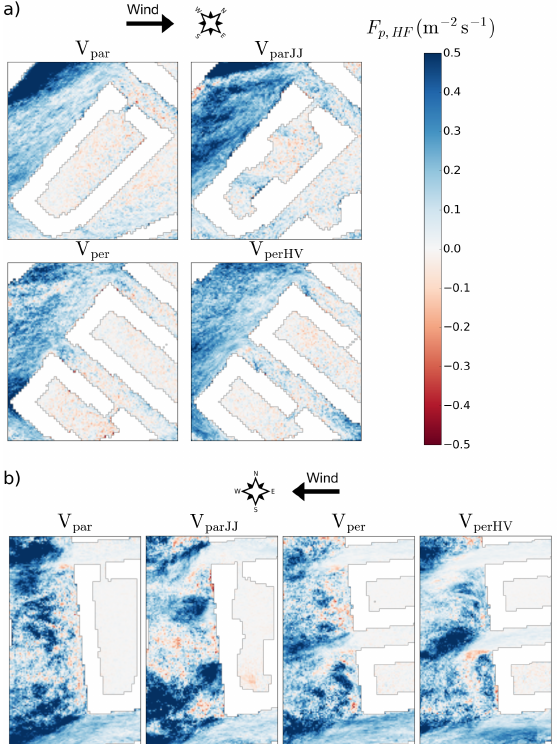
Figure A2. 5-min mean high-frequency vertical turbulent particle flux density F p , HF (m − 2 s − 1 ) at z = 20 m under the ( a ) general and ( b ) wintry inflow conditions. The analysis area is marked in Figure 2 with a black solid